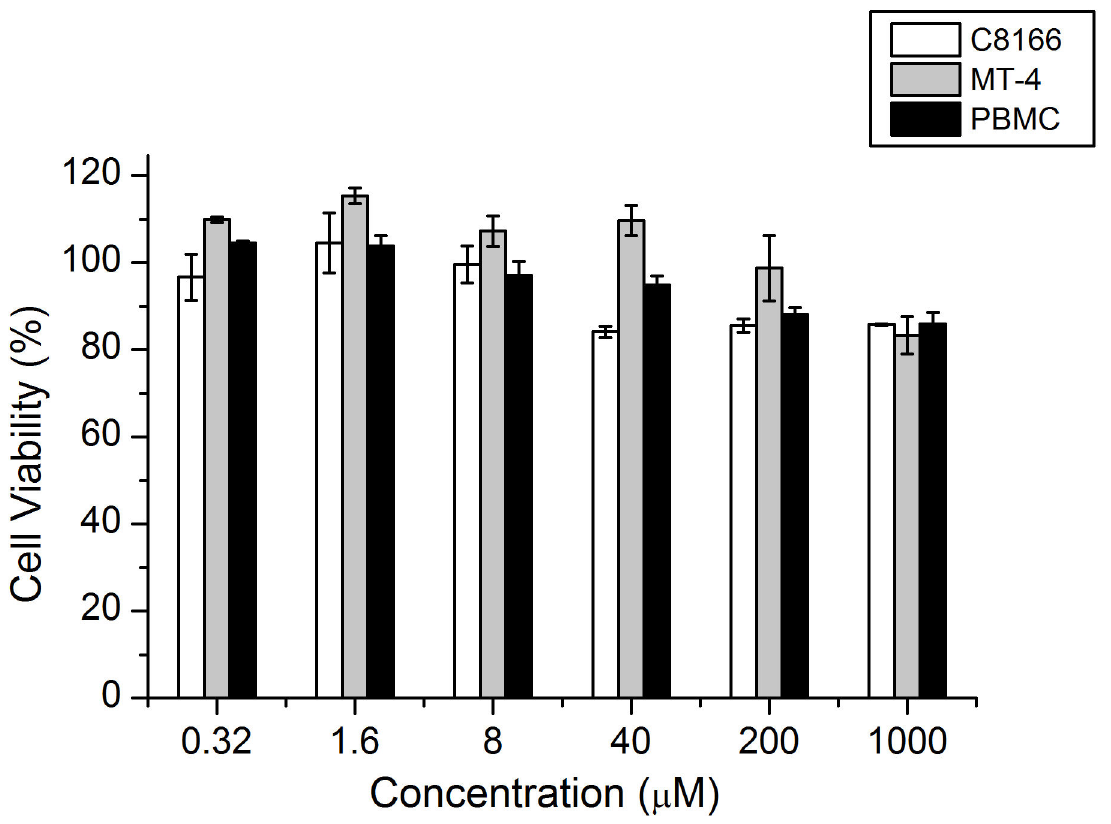
Figure 2. Cytotoxicity of DB-02 in C8166, MT-4 and PBMC using MTT methods. DB-02 showed low cytotoxicity to all the three types of aforementioned cells above. CC of these cells were all >1000μM, 50